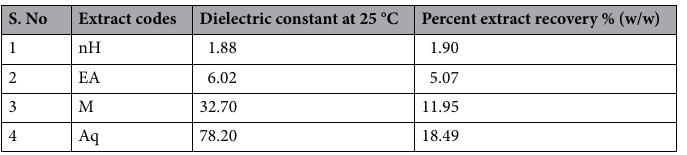
Table 1. Extract recovery of Fagonia cretica samples. * nH n-Hexane, EA Ethyl Acetate, M Methanol, Aq Aqueous.